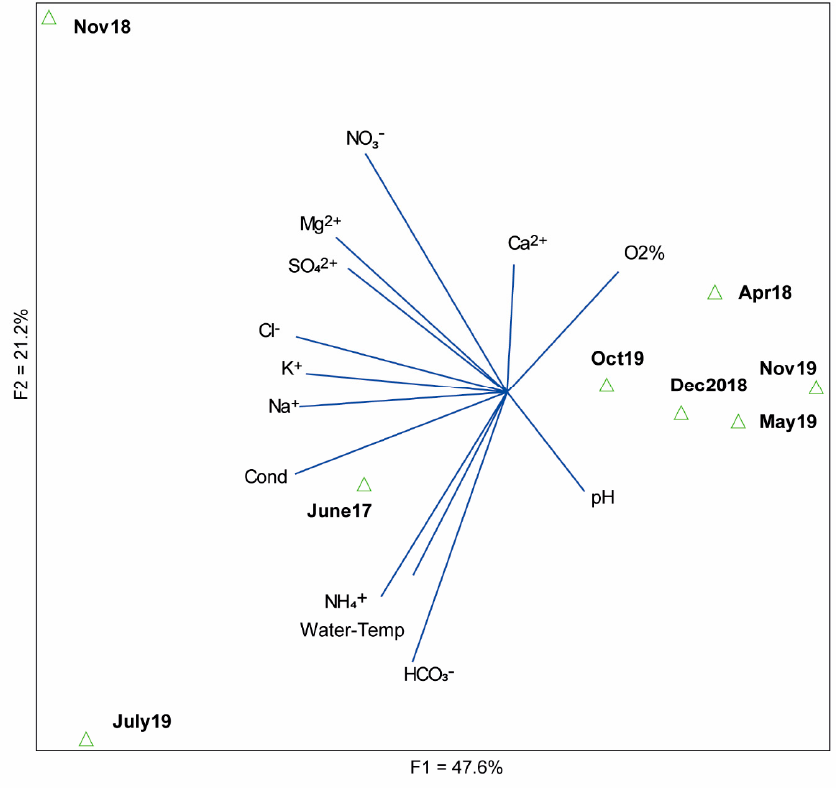
Figure 3. Principal component analysis performed on physical and chemical data.